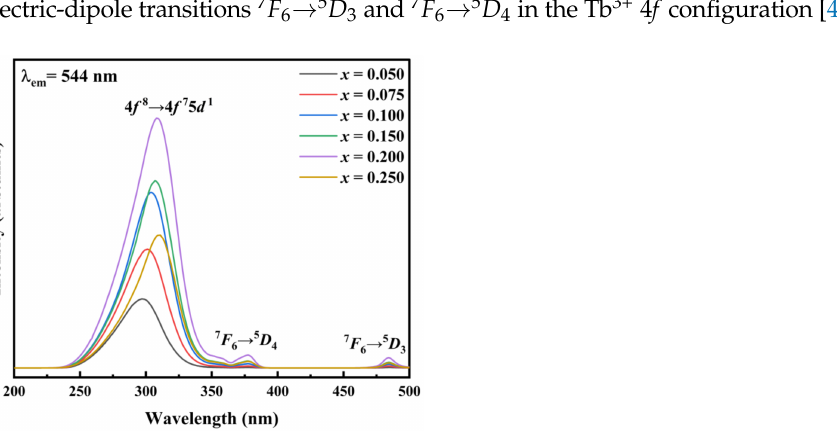
Figure 9. Excitation spectra of (ZrO 2 ) 92 (Y 2 O 3 ) 8 − x (Tb 4 O 7 ) x ( x = 0.050–0.250) crystals before annealing and monitored at 544 nm.